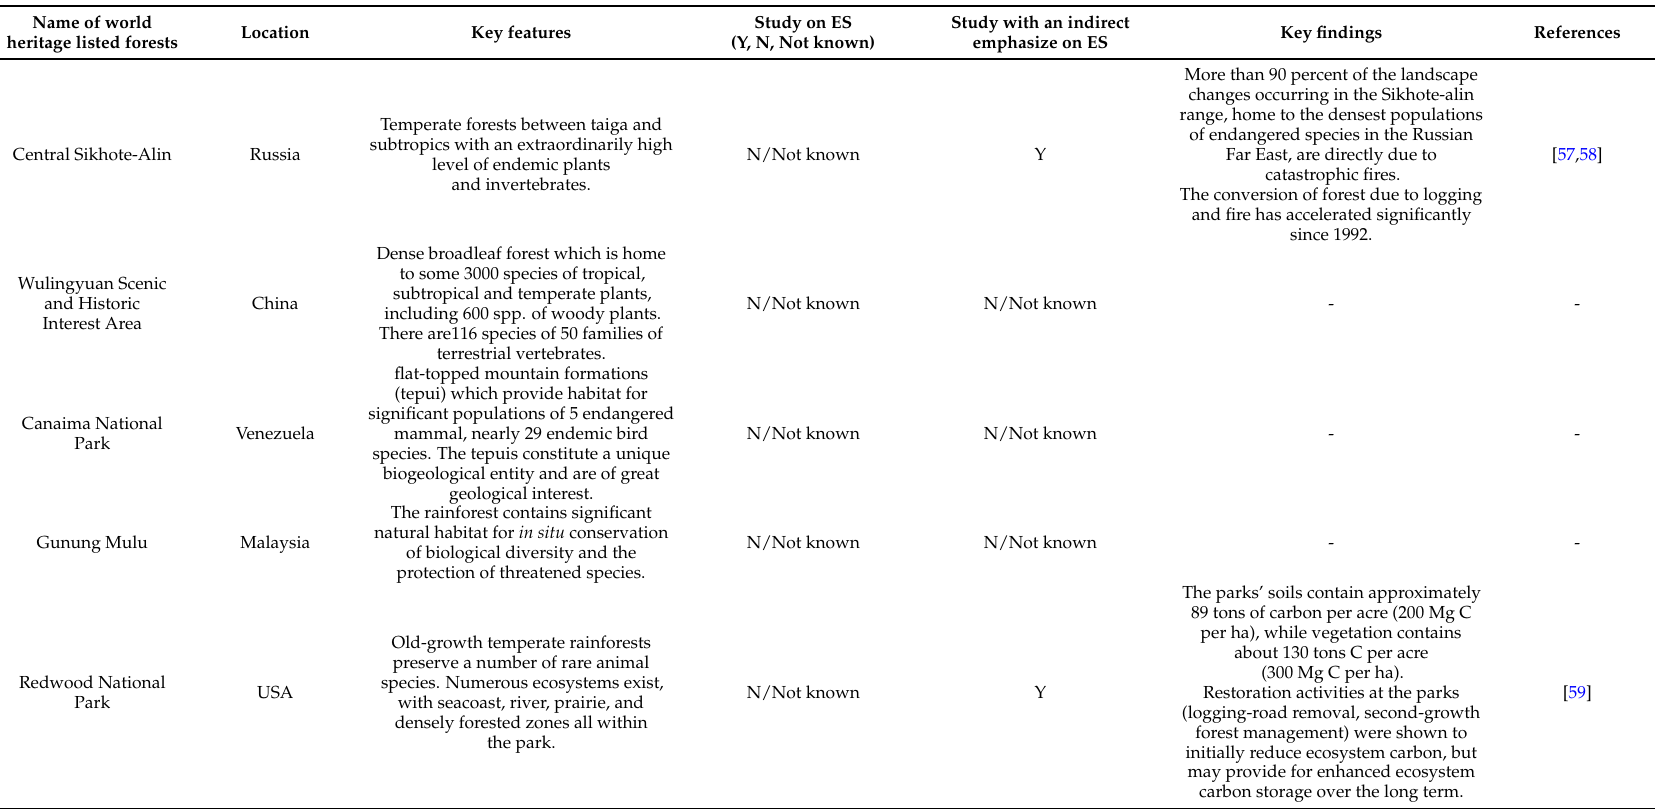
Table A1. A number of globally significant forested landscapes which have been listed as world heritage